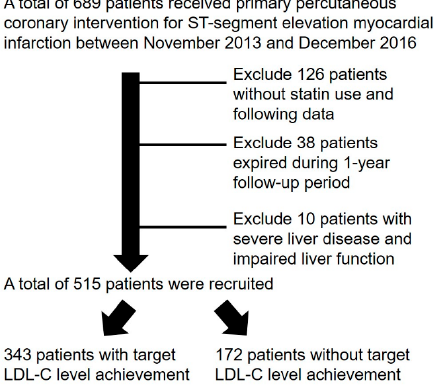
Figure 1. Patients disposition. Abbreviation: LDL-C: low-density lipoprotein cholesterol.